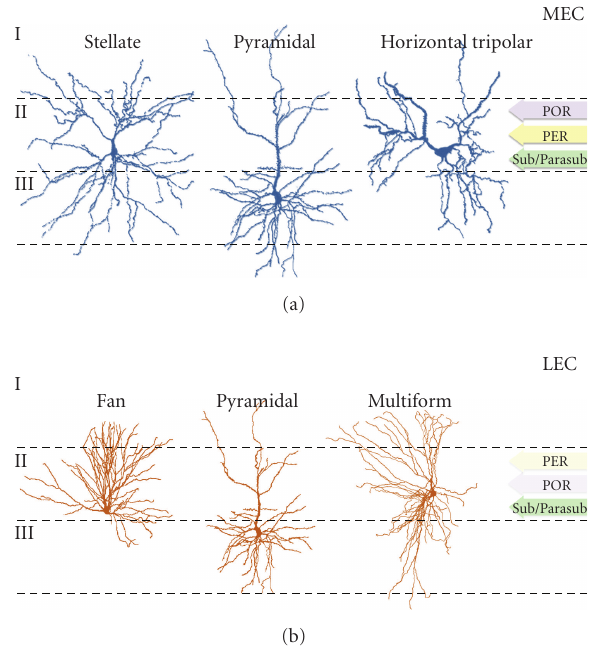
Figure 1: Morphological and connectional heterogeneity among principal neurons in layer II of the medial and lateral entorhinal areas. (a) In the medial entorhinal cortex (MEC), stellate cells are the most numerous class of excitatory neuron in layer II. However, pyramidal neurons and horizontal tripolar cells also reside in layer II and send a ff erents to the hippocampus via the perforant pathway. Layer II neurons in the MEC receive input from the postrhinal cortex (POR), and to a lesser extent from the perirhinal cortex (PER), and also from the subiculum/parasubiculum (Sub/Parasub) of the hippocampus. Whether these inputs preferentially contact a particular morphological class of layer II neuron remains to be determined. (b) In the lateral entorhinal cortex (LEC), fan cells are the most frequently observed, but pyramidal and multiform neurons also contribute axonal input to the perforant pathway. Layer II neurons of the LEC receive strong input from the PER, weaker input from the POR, as well as from the Sub/Parasub region of the hippocampus proper. All connectivity information is based on a review by Van Strien and colleagues